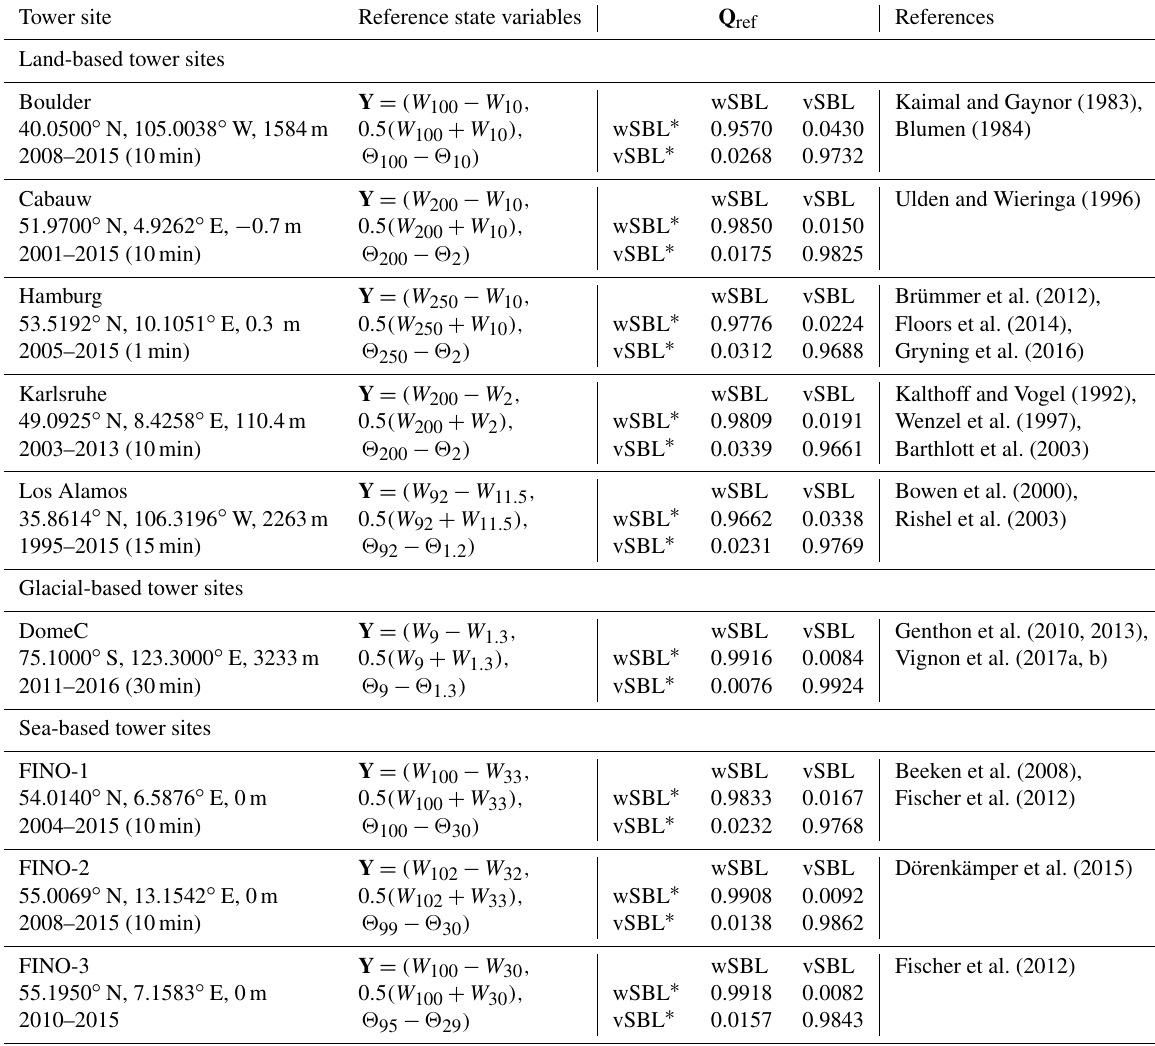
Table 1. Basic information about the different land-, glacial-, and sea-based tower sites (geographical coordinates, time resolution) and their individual reference HMM state variable inputs Y (wind speeds W h and static stabilities (cid:49)(cid:50) with their observational levels h ) and reference transition probability matrices ( Q ref ) of HMM analyses estimated from Y . Starting regimes for the transition probability matrices are denoted with a star. Transition probability matrices at Hamburg, Los Alamos, and DomeC are transformed to a 10min time resolution, so a direct comparison to other sites is possible. To retrieve original transition probability matrices at these sites, the 1 / 10, 3 / 2, and 3 matrix powers (respectively) must be